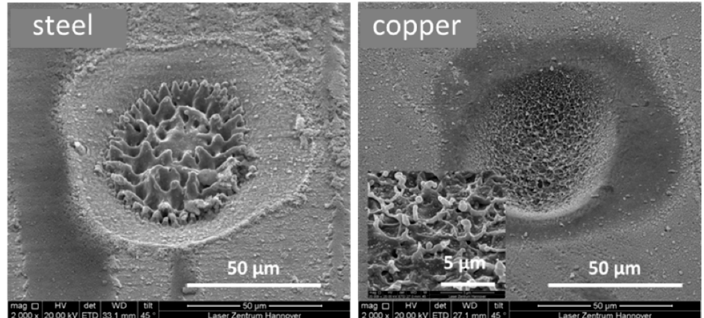
Figure 6. SEM images of ablation craters on steel ( left ) and copper ( right ), generated by 100 laser pulses (30 fs) at fluence of 10 J/cm².